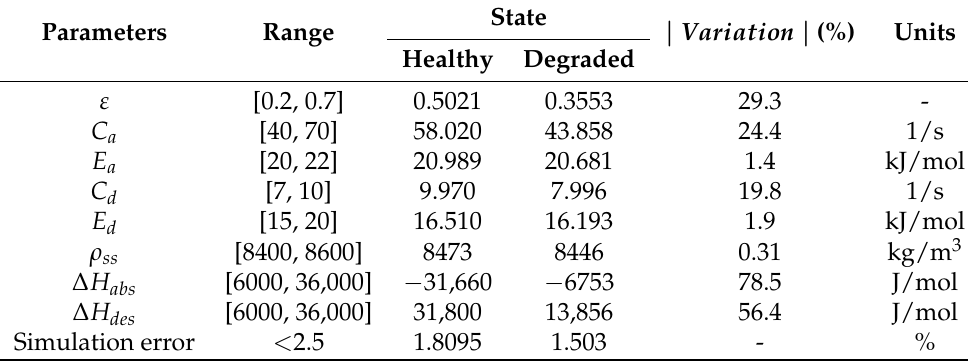
Table 3. Comparison of tank parameters.